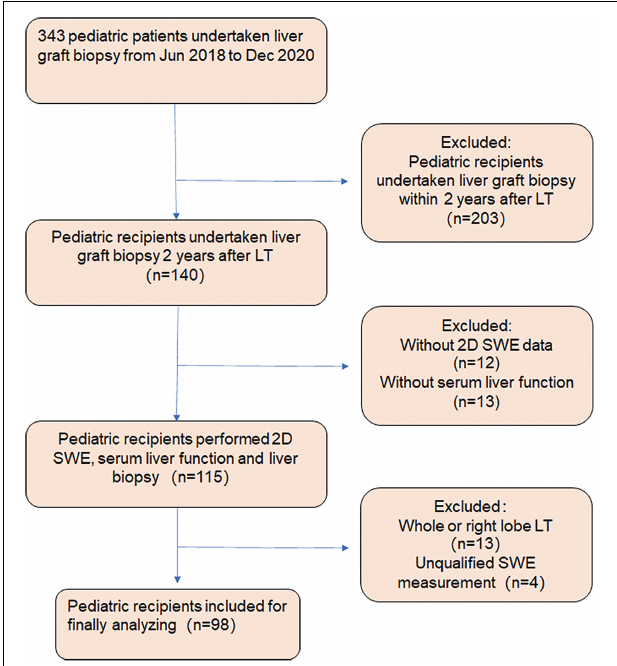
FIGURE 1 | Flowchart of the study design protocol. Three hundred forty-three pediatric patients underwent liver graft biopsy from June 2018 to December 2020. One hundred and forty pediatric patients received liver biopsy within 2 years after liver transplantation (LT). The pediatric patients without 2D SWE data ( n = 12) or serum liver function ( n = 13), with whole liver or right lobe transplantation ( n = 13) and unsuccessful 2D SWE examination ( n = 4), were excluded from the study. Ninety-eight pediatric patients were recruited, including 86 subjects with left lateral lobe transplantation and 12 with left lobe